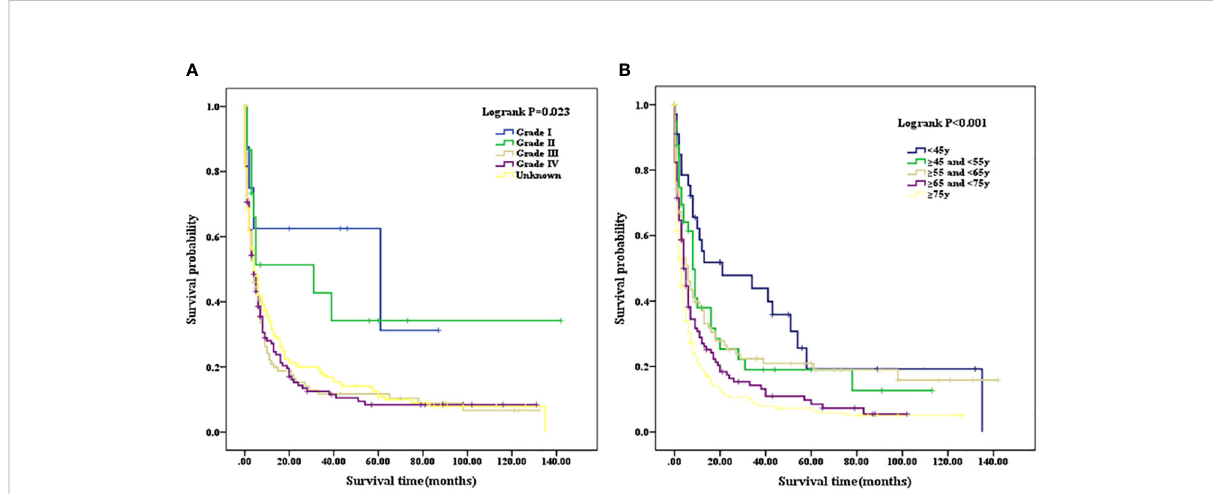
FIGURE 2 (A) Kaplan – Meier analysis of survival curves strati fi ed by grade in PSC cohort. (B) Kaplan – Meier analysis of survival curves strati fi ed by age stages in PSC cohort. PSC, pulmonary sarcomatoid